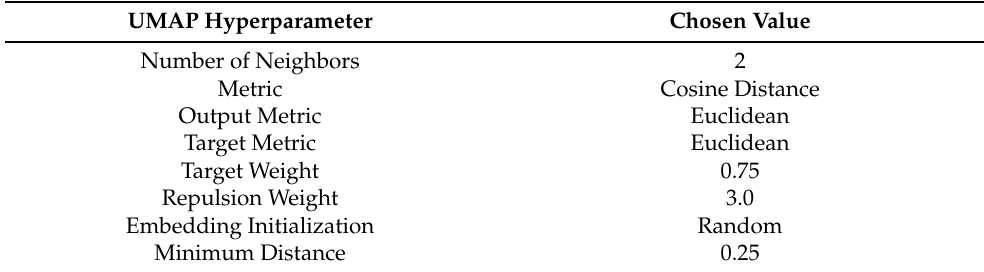
Table 1. UMAP tuned hyperparameters in the pipeline.